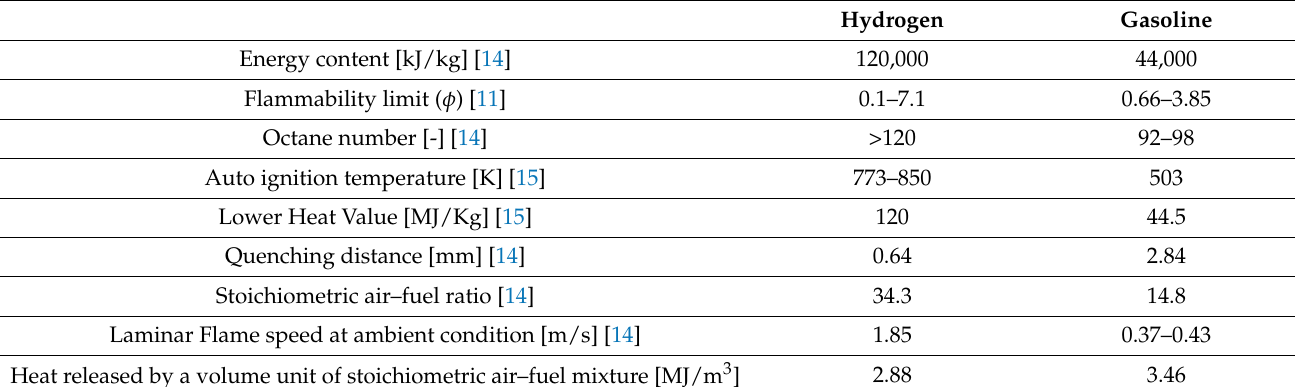
Table 1. Main characteristics of hydrogen and